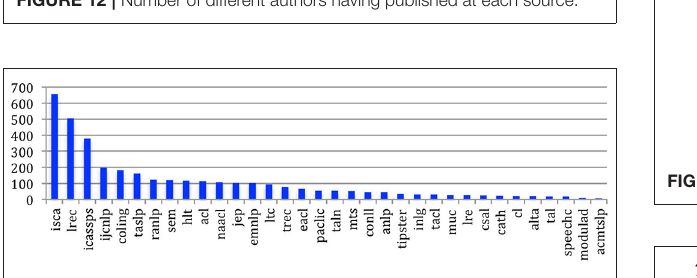
FIGURE 13 | Average number of documents at each venue (conferences) or issue (journals).